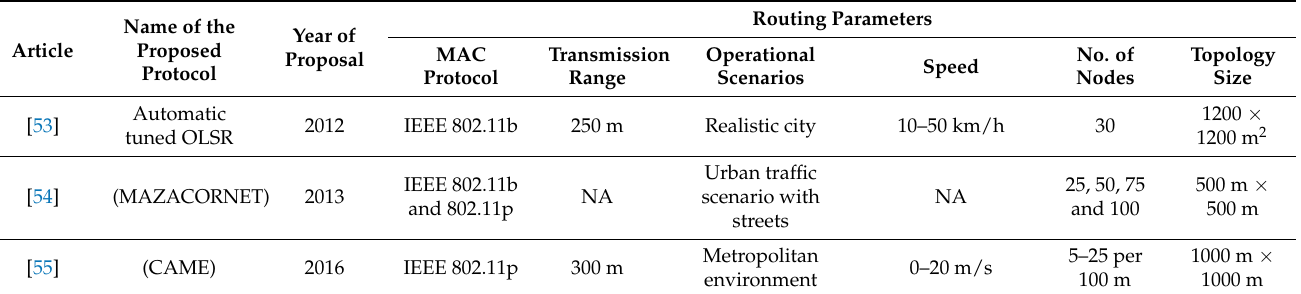
Table 14. Routing parameters of urban scenarios with streets-based routing protocols.